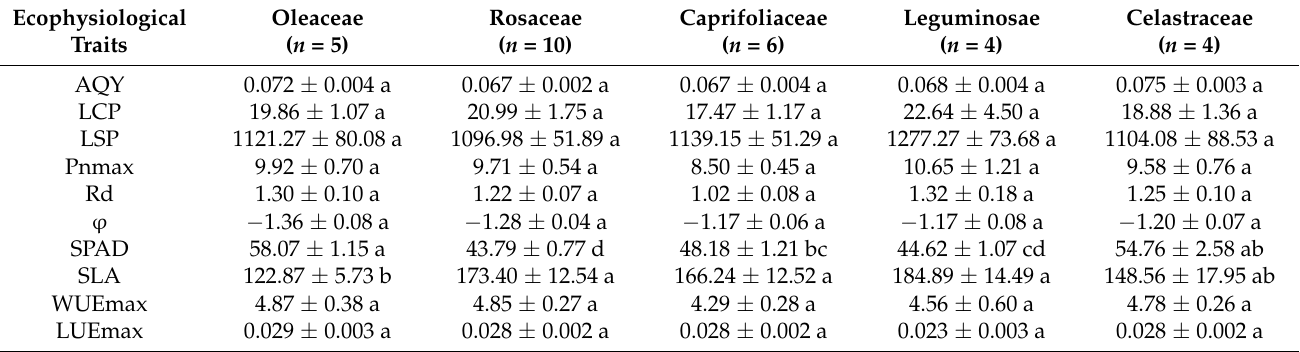
Table 4. Results of a one-way ANOVA of ecophysiological traits of species of different families. The values were ecophysiological indicators of five families (mean ± SE), different lowercase letters indi- cate significant differences among different families for the same parameter ( p < 0.05). Abbreviations are shown in Table